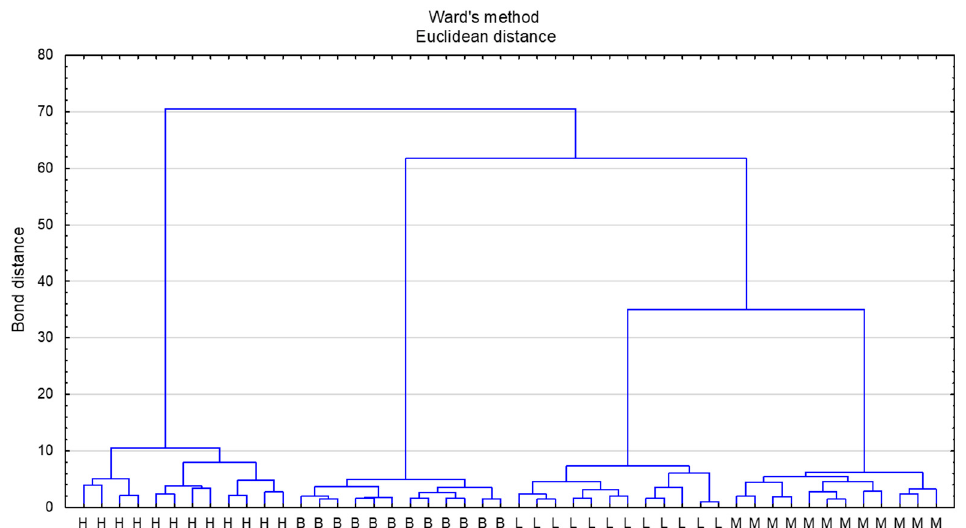
PC1 vs. PC2; L—lime honey, M—multifloral honey, H—honeydew honey, B—buckwheat honey.